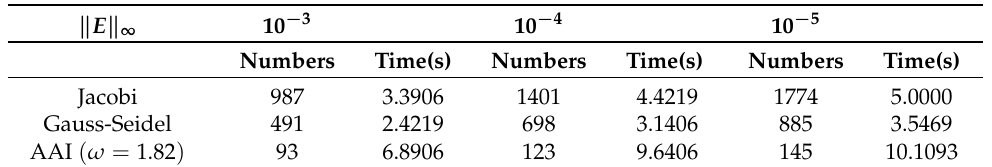
Table 3. The iteration numbers and time(s) of Jacobi, Gauss-Seidel and the AAI algorithm under the different error controls when l = m = s = 51, h = 1 / 50